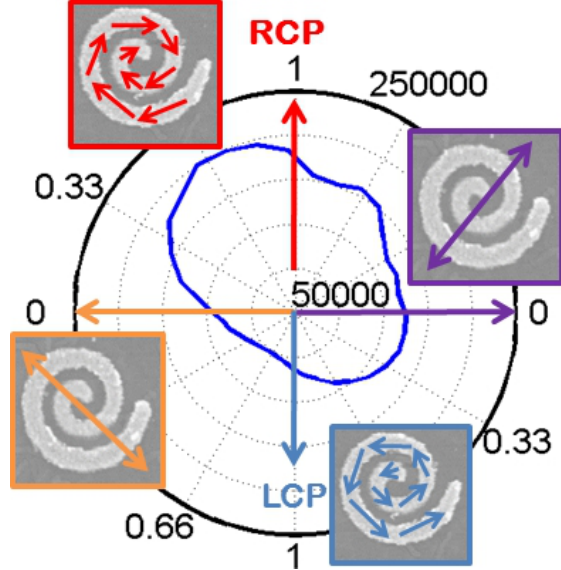
Figure 3: SHG response to eccentricity and handedness of circular polarization. Horizontal axis corresponds to the two linear-polarized states shown by the purple and orange lines. The vertical axis corre- sponds to completely circular polarizations. SHG: Second-harmonic